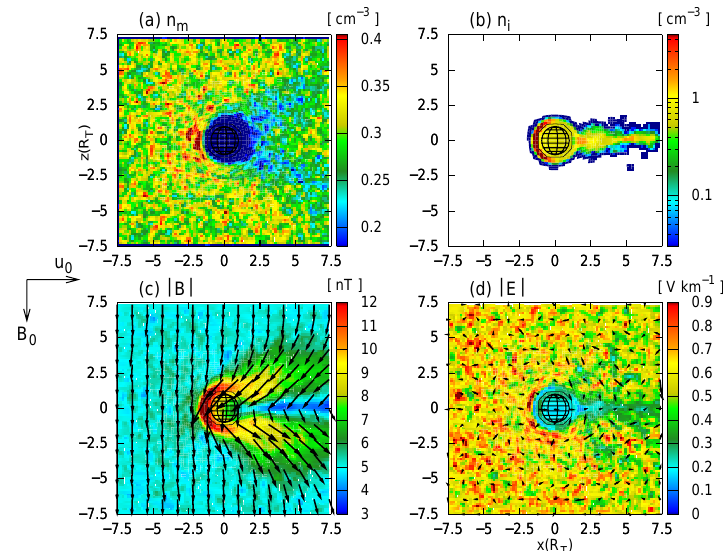
Fig. 7. Interaction between Titan’s ionosphere and a slightly super-alfv´enic, yet subsonic and submagnetosonic plasma flow – Cut through the polar plane. The physical quantities shown in the figure are the same as in Fig. 5. Mach numbers of the upstream plasma flow: M A =1.87 (alfv´enic), M S =0.57 (sonic) and M MS =0.55 (magnetosonic).